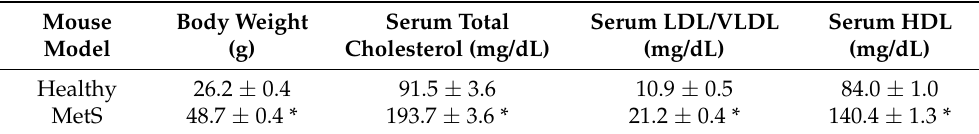
Table 1. Characterization of serum lipid levels in healthy and MetS mouse